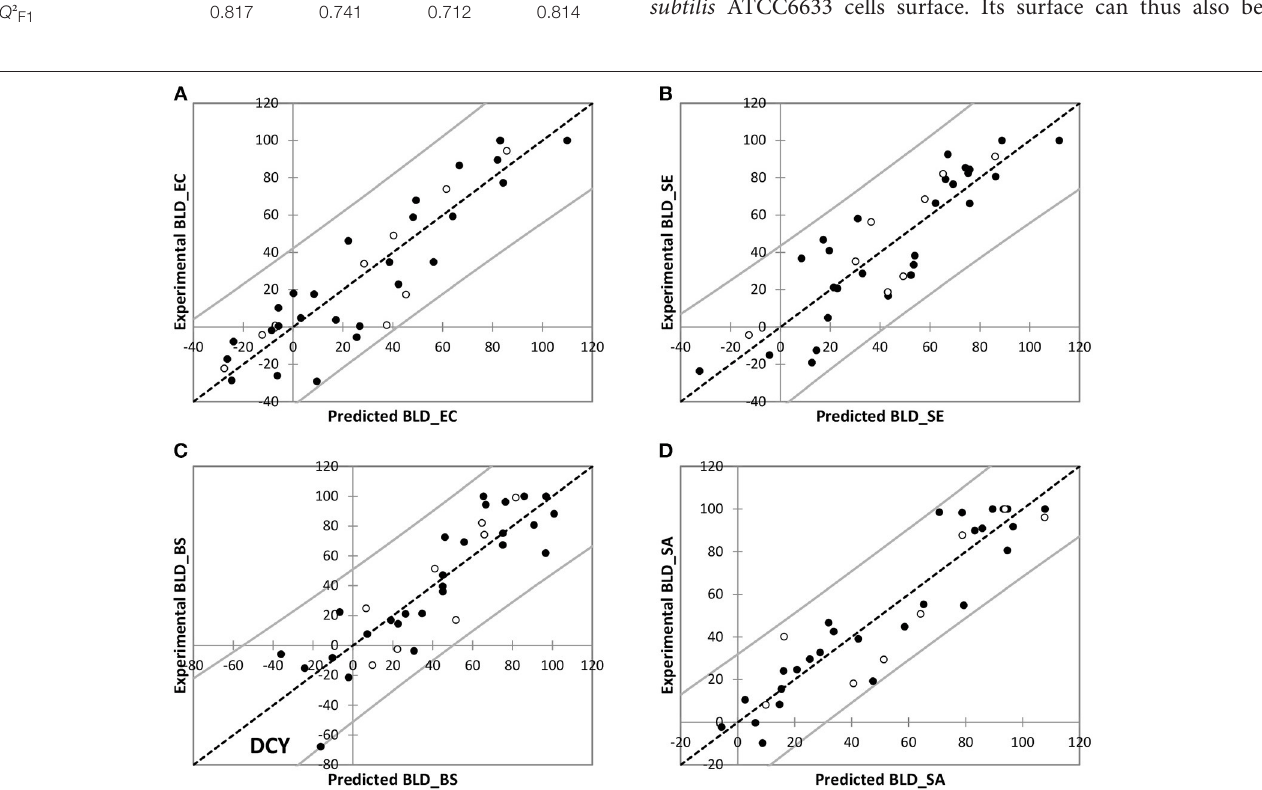
FIGURE 2 | Experimental vs. predicted BLD values for training (•) and test ( ◦ ) polyphenols for E. coli ATCC25922 (A) , S. Enteritidis E0220 (B) , B. subtilis ATCC6633 (C) , and S. aureus CNRZ3 (D) .